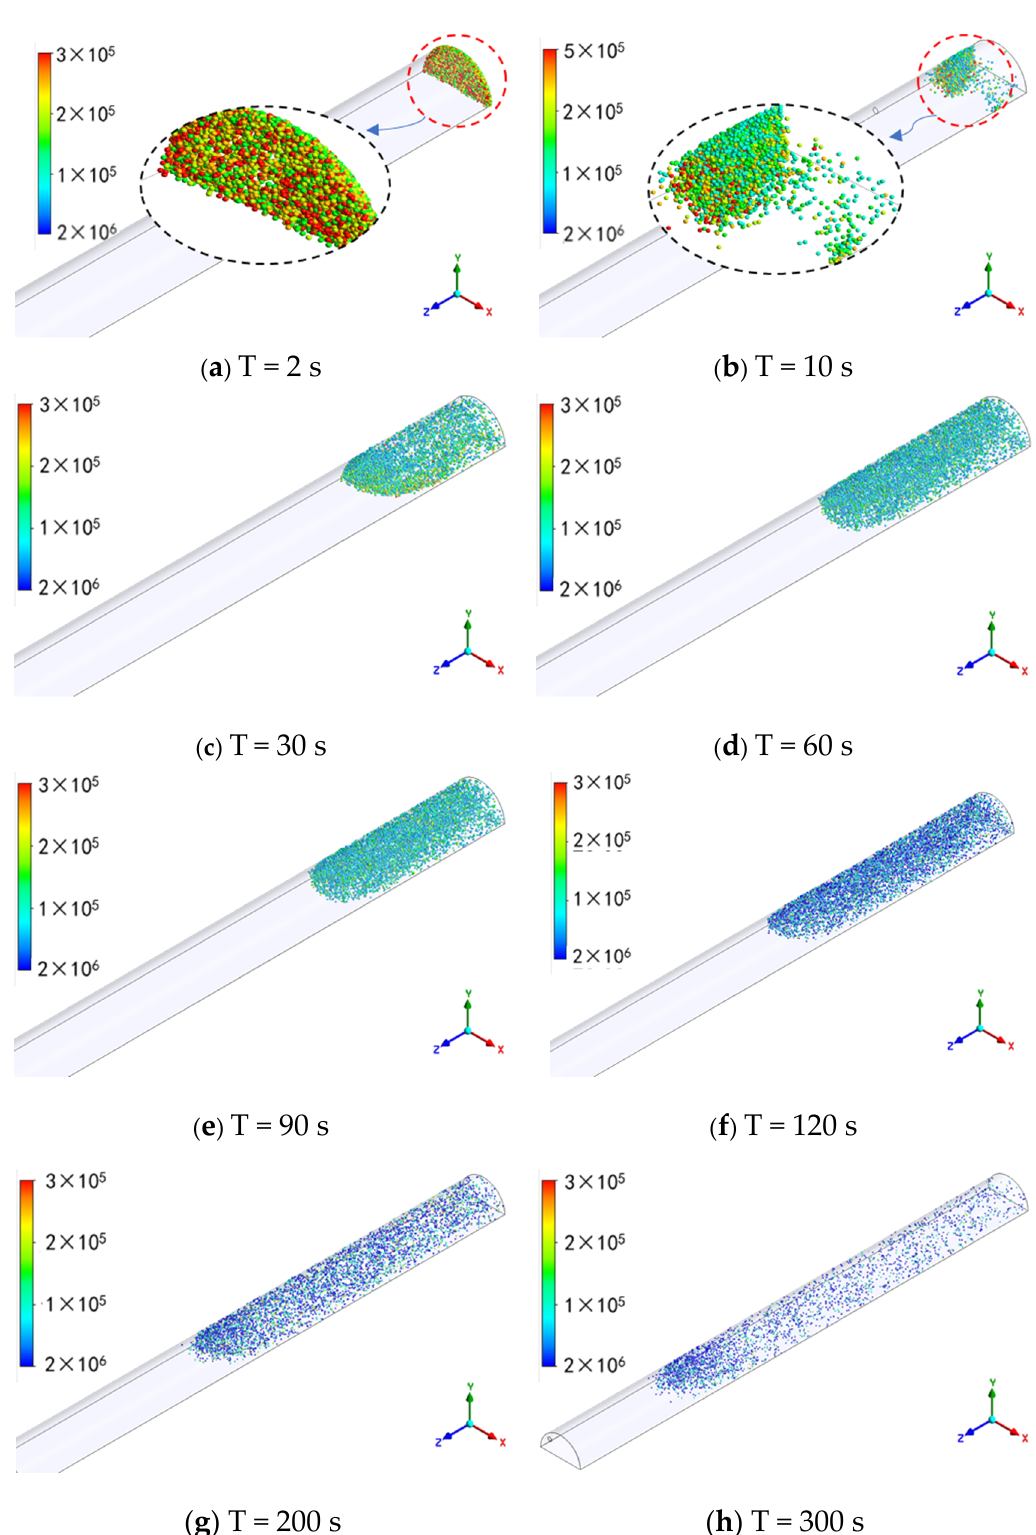
Figure 7. Trajectory of blasting dust over time.